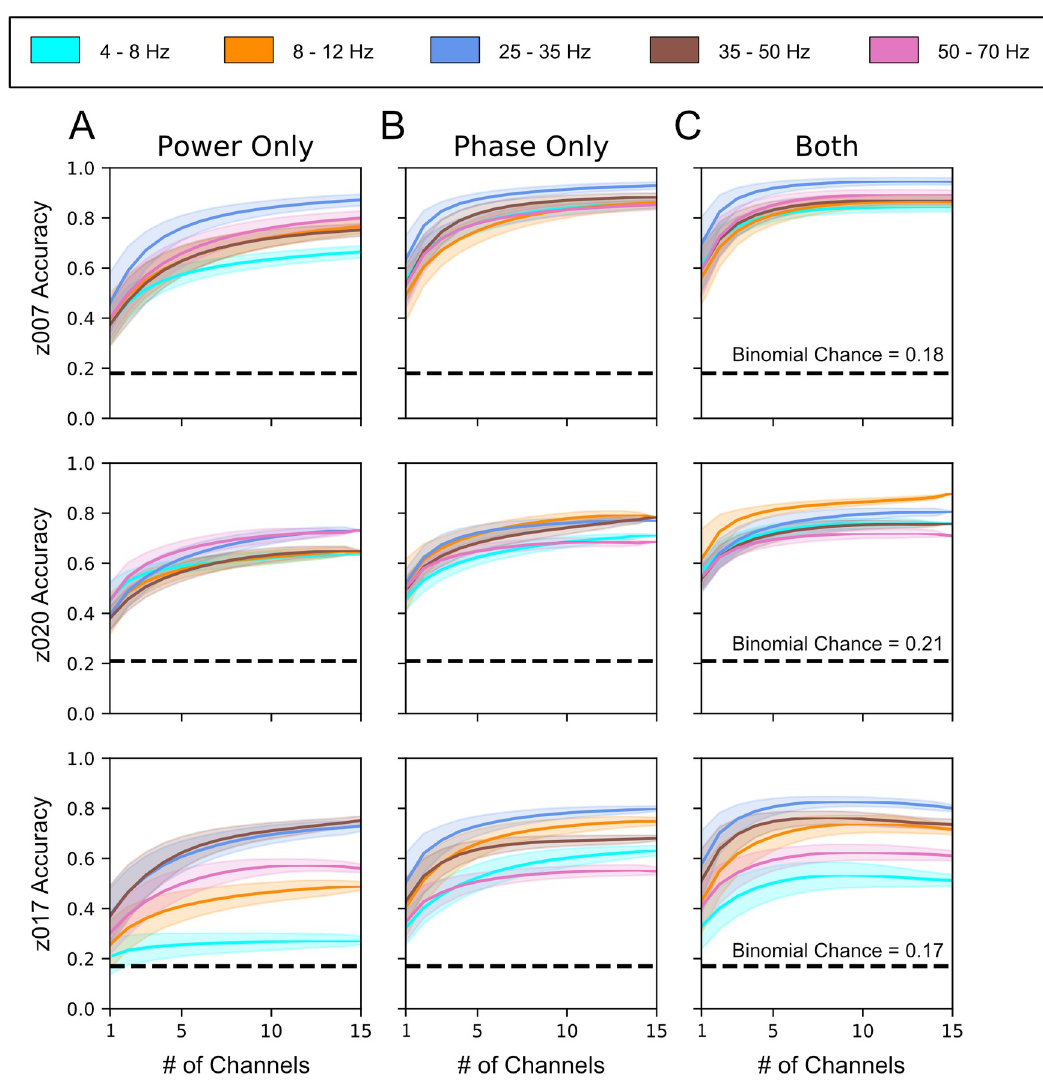
Fig 9. LFP phase and power provide independent and additive information for vocalization classification. Channel-adding curves calculated by repeatedly training classifiers with an increasing number of randomly selected channels (see Methods). (A-C) Channel-adding curves showing classifier performances with either (A) all LFP phase information removed, (B) all LFP power information removed, or (C) with both phase and power used as independent features. Each row corresponds to data from the highest-yield day for each bird. These vocal and non-vocal classification events are collectively referred to as classes (see Methods). z007 n = 98 for each of 7 classes (1, 2, 3, 4, 5, i (introductory note), Silence); z020 n = 91 for each of 6 classes (1, 2, 3, 4, i (introductory note), Silence); and for z017 n = 52 � for each 8 classes (1, 2, 3, 4, 5, 6, 7, Silence). The results of up to 15 channels are shown to allow for direct comparison across subjects. Dark lines show the mean for each vocalization class, shaded areas give the standard deviation over the bootstrapped analysis using n = 5,000 repetitions across 5 cross-validation folds. The p-value for all of the binomial chances calculated for each bird was 0.05. � The number of instances for each class was limited by Syllable 7, which is an intra-motif